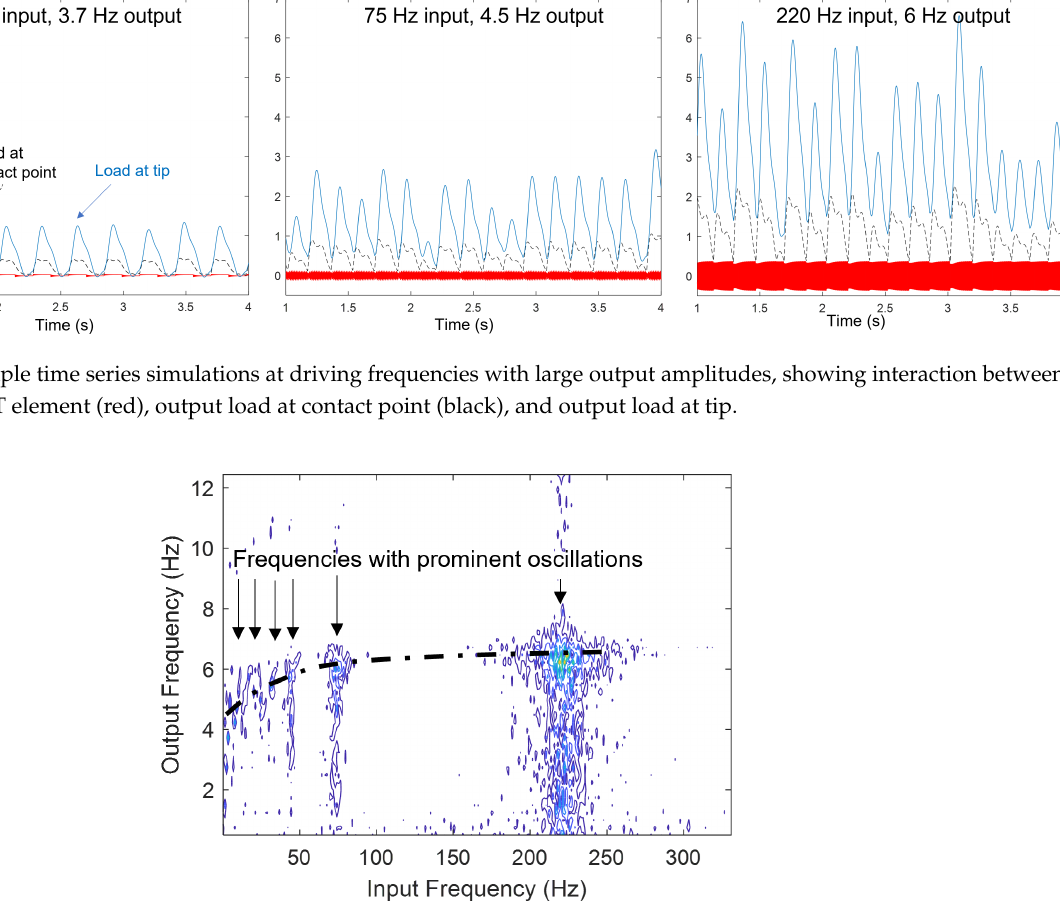
Figure 5. Contour map of simulated spectral content, from FFT of output motion versus input frequency. High-amplitude oscillations with impact-based amplification occur at intermittent driving frequencies up to piezoelectric bender resonance, with dominant output frequencies slowly increasing from 2.5 to 6.5